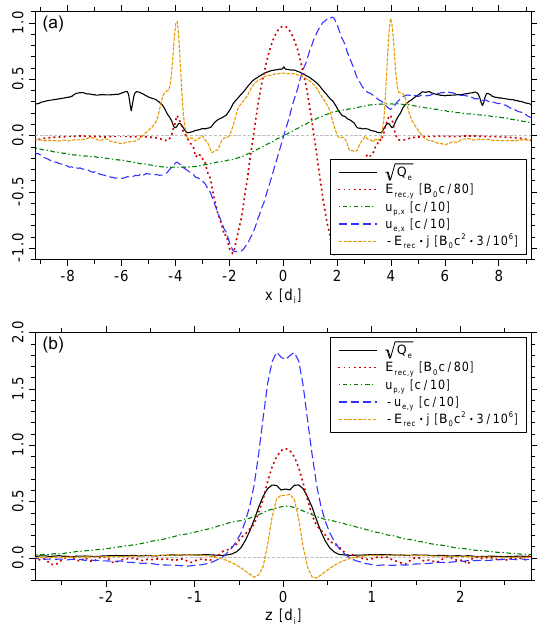
Figure 3. Cuts for the non-gyrotropy index Q e , the reconnection electric field E rec , the scalar product the of total electric field and current density E rec · j , and the bulk velocities u , along the z = 0 line (a) and along x = 0 (b)